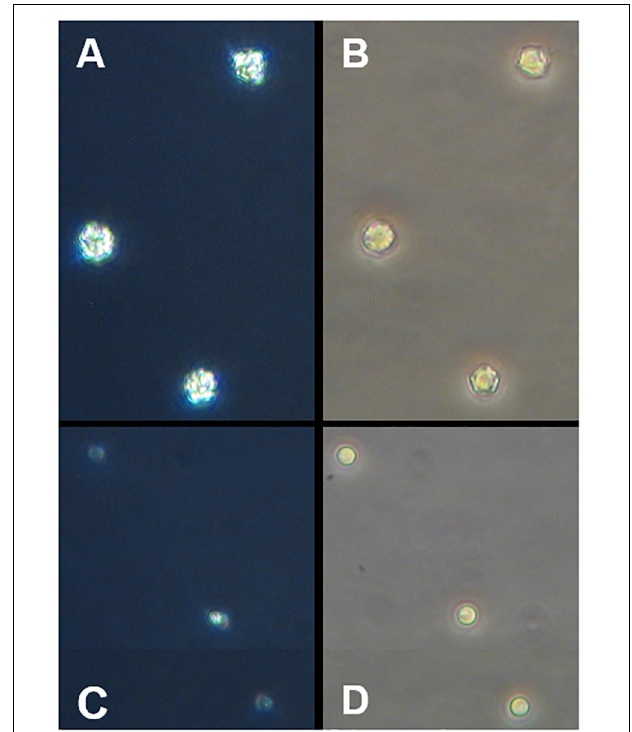
FIGURE 1 | Microscopic images of E. huxleyi (400x magnification). (A) Calcified cells under polarized light, (B) light microscopic picture from the same cells, (C,D) display cells after the treatment with acid and